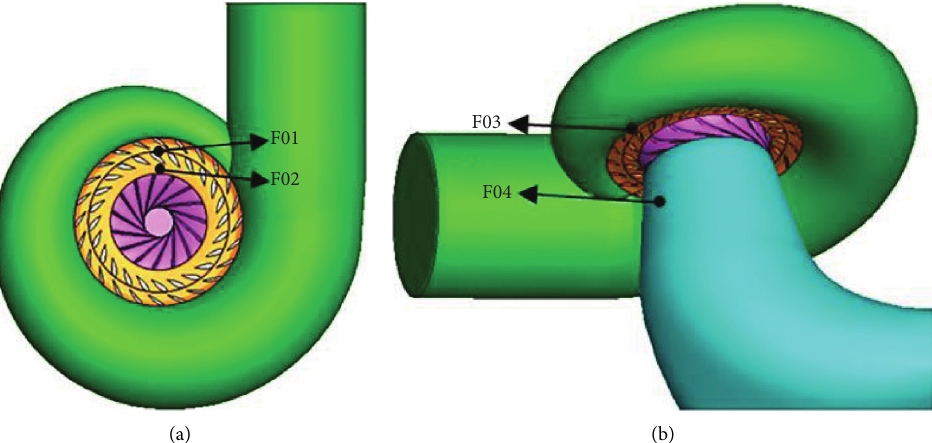
Figure 9: Pressure monitoring points in the fluid flow channels. (a) Location for measuring points F01 and F02. (b) Location for measuring points F03 and F04.